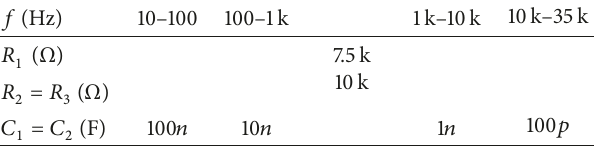
Table 1: Circuit parameters for different frequency